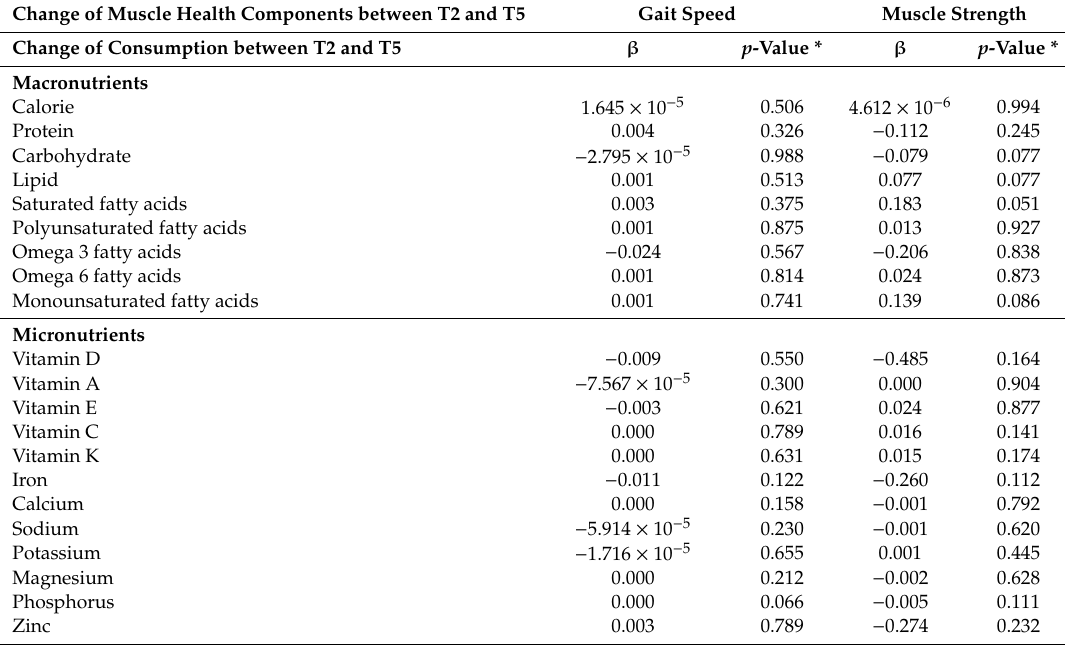
Table 4. Association between longitudinal changes in macro- and micronutrient consumption and longitudinal changes in muscle health